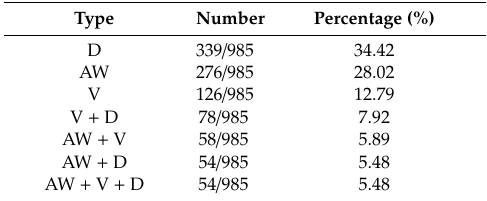
Table 4. Number of infringements that were related to animal welfare (AW), vehicle (V) and documents (D) or to a combination of two or three of